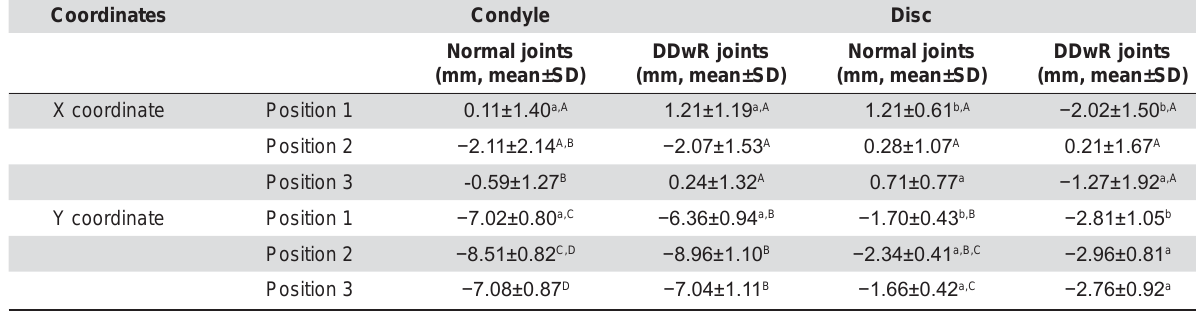
Table 2- Condyle and disc coordinates in normal and DDwR joints for Position 1, Position 2, and Position Coordinates